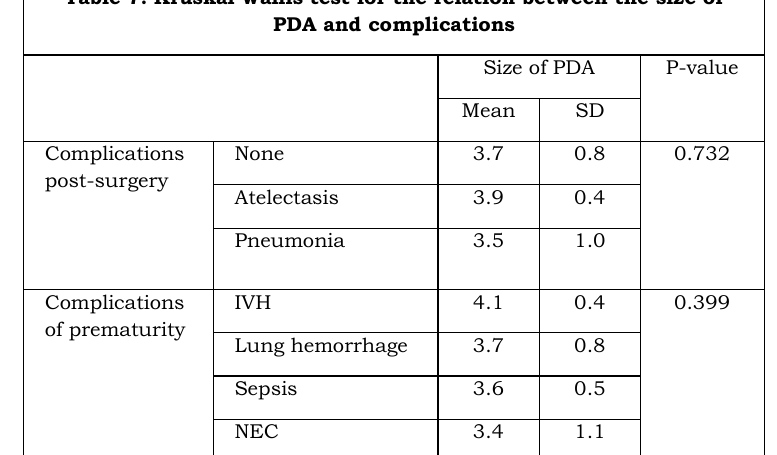
Table 7: Kruskal Wallis test for the relation between the size